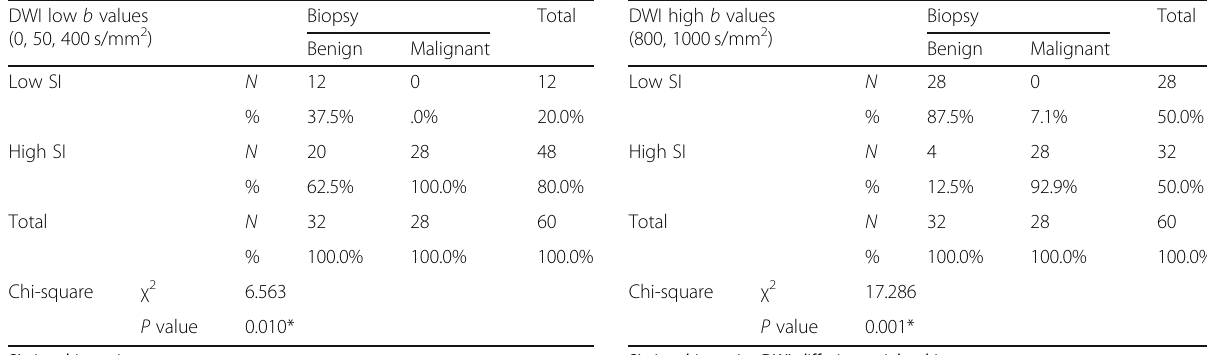
Table 3 Distribution of the studied cases according to